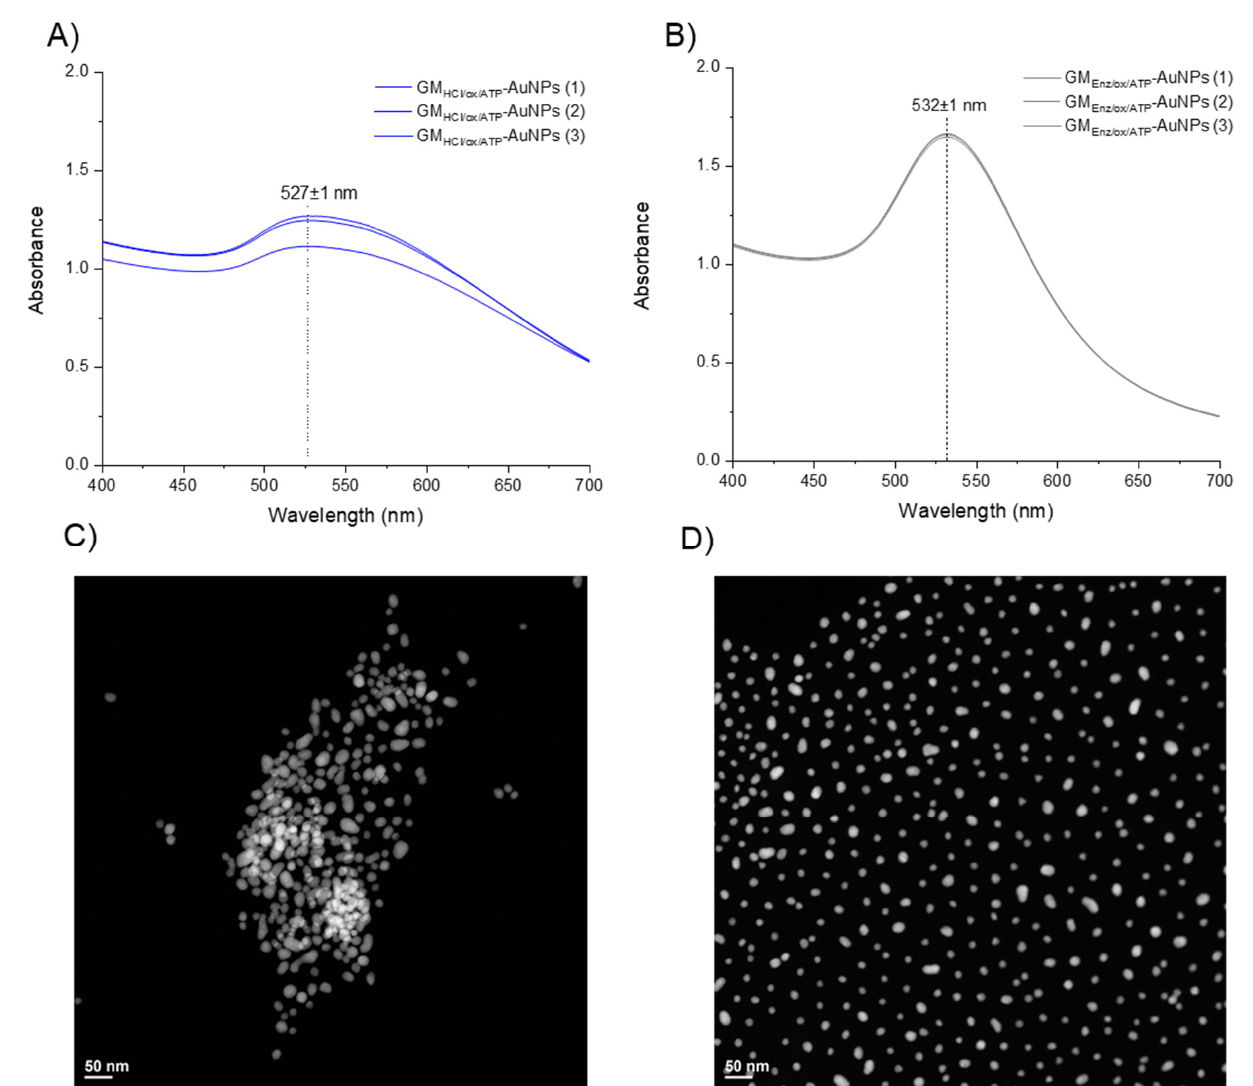
Figure 7. ( A , B ) Surface plasmon resonance of gold particles upon functionalization with GM HCl/ox/ATP and GM Enz/ox/ATP , respectively ( ≈ 0.012 nM Au particles). ( C , D ) TEM images of gold particles upon functionalization with GM HCl/ox/ATP and GM Enz/ox/ATP , respectively.